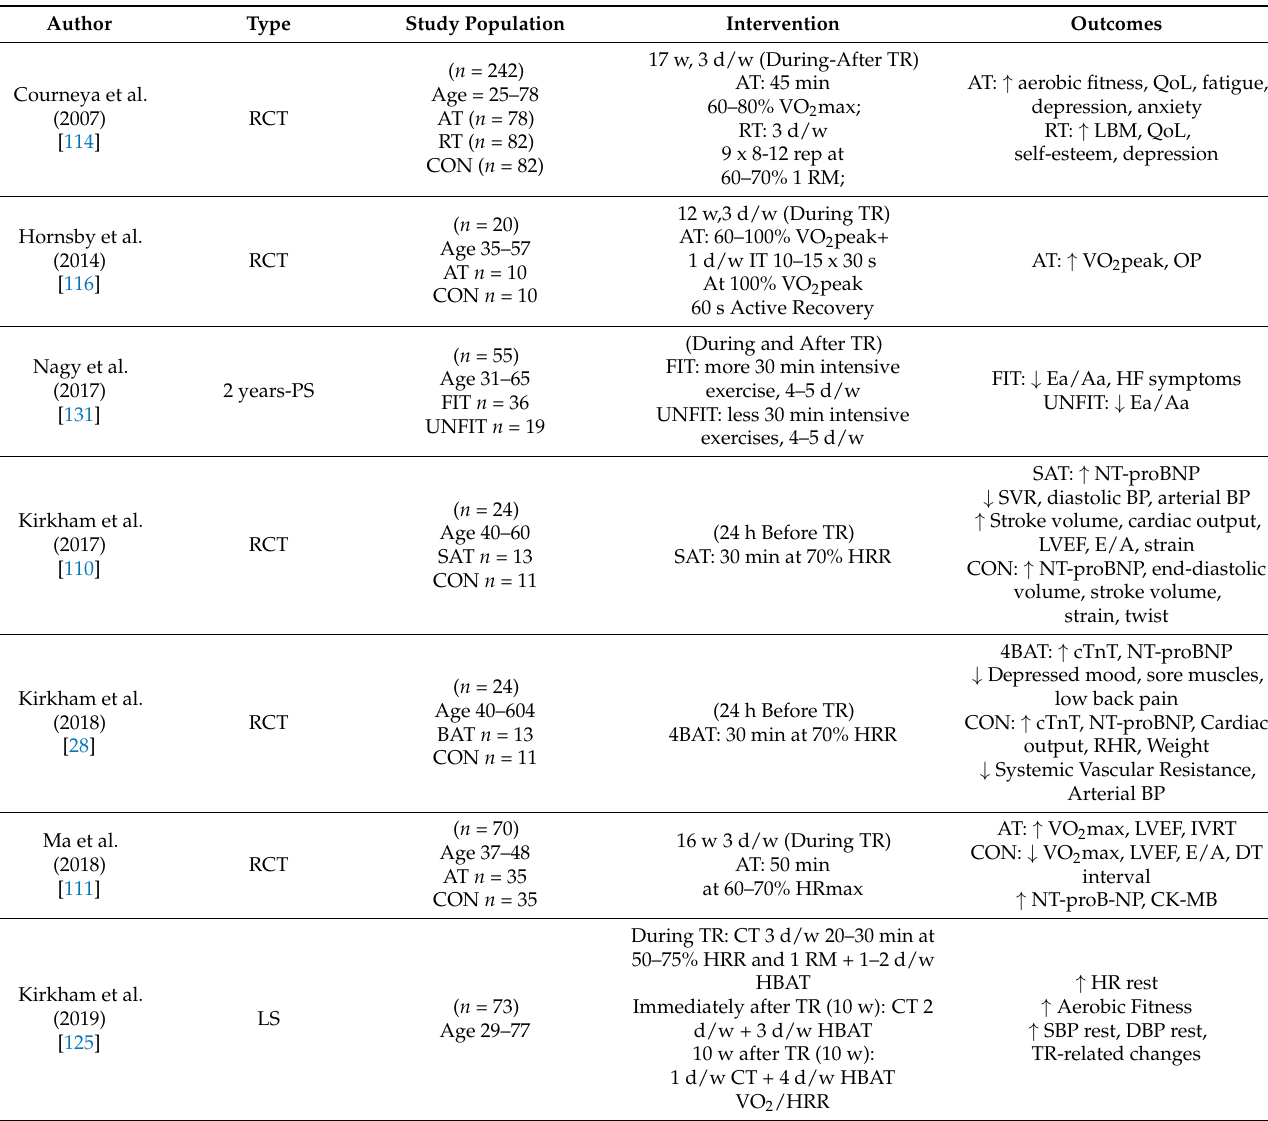
Table 1. Effect of physical exercise on cardiotoxicity before, during, and after BC anthracycline treatment. Abbreviations: RC, Randomized Control Trial; NRCT, No-Randomized Control Trial; RPT, Randomized Prospective Trial; LS, Longitudinal Study; CSS, Cross Sectional Study; PS, Prospective Study; TR, Treatment; AT, Aerobic Training; RT, Resistance Training; CT, Combined Training; SAT, Single Aerobic Training; 4BAT, Four Bout Aerobic Training; HBAT, Home-based Aerobic Training; HIIT, High Intensity Interval Training; ST, Supervised Training; NST, NO-Supervised Training; CON, NO-exercise; w, week; d, days; min, minutes; s, seconds; rep repetitions; 1-RM, One Repetition Maximum; VO 2 max, Maximum Volume of Oxygen; VO 2 peak, Peak Oxygen Uptake; OP, Oxygen Pulse; PPO, Peak Power Output; QoL, Quality of Life; LBM, Lean Body Mass; FIT, Physically Active; UNFIT, NO-Physically Active; SVR, Systemic Vascular Resistance; BP, Blood Pressure; LVEF, Left Ventricular Ejection Fraction; IVRT, Isovolumetric Relaxation Time; DT, E peak deceleration time; HRR, Hearth Rate Reserve; RHR, Resting Hearth Rate; cTnT, Cardiac Troponin T; NT-proBNP, N-terminal-pro B-type natriuretic peptide; CK-MB, phosphokinase; Hb, Hemoglobin; HF, Hearth Failure; BC, Breast Cancer; W, watt; ↑ , increase; ↓ ,